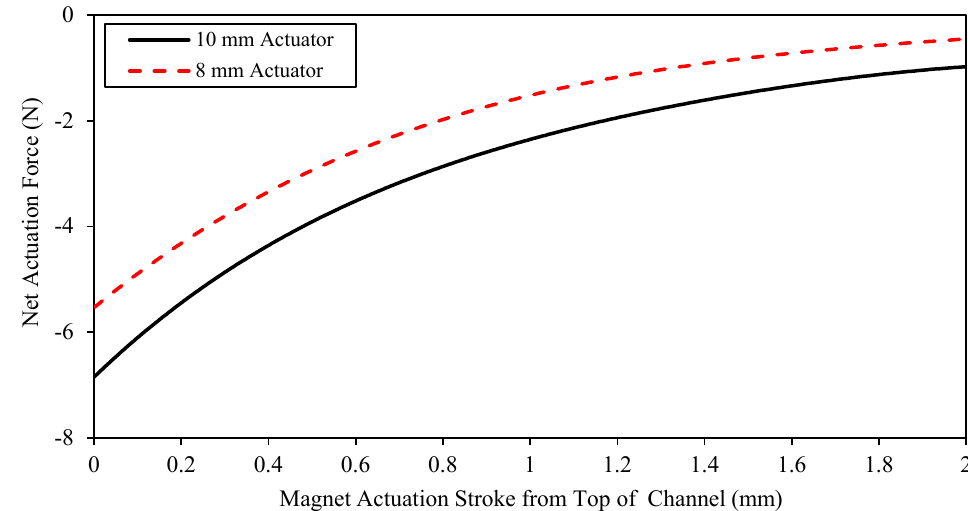
Figure 9. Net repulsion force on the magnet along its stroke from the upper to the lower end of channel for two actuator diameters (8 and 10 mm).